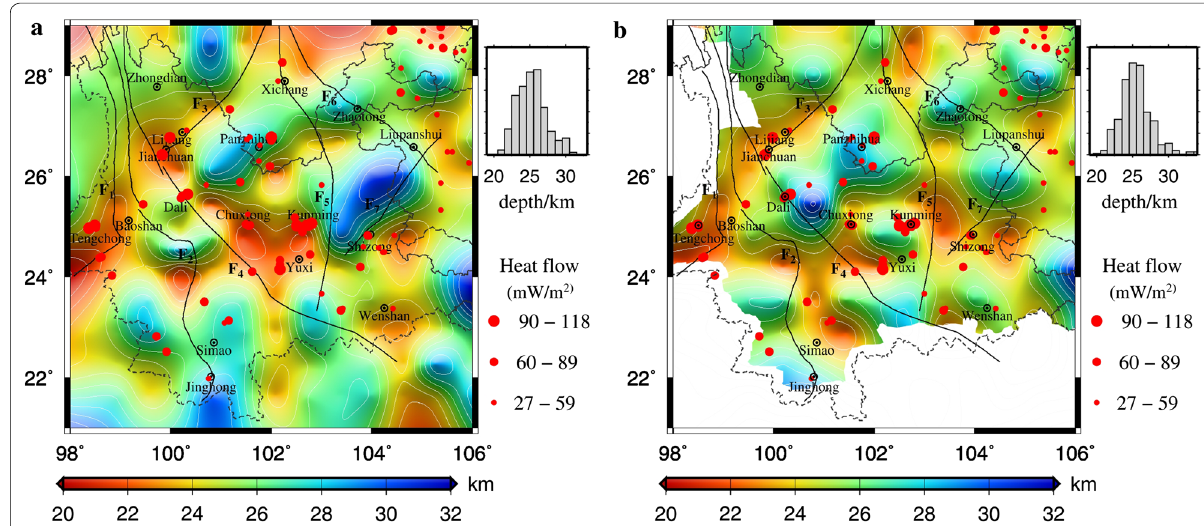
Fig. 3 Depth of the Curie surface. a from NGDC-720 model; b from aeromagnetic anomaly. Red points are the measurement sites of the surface heat